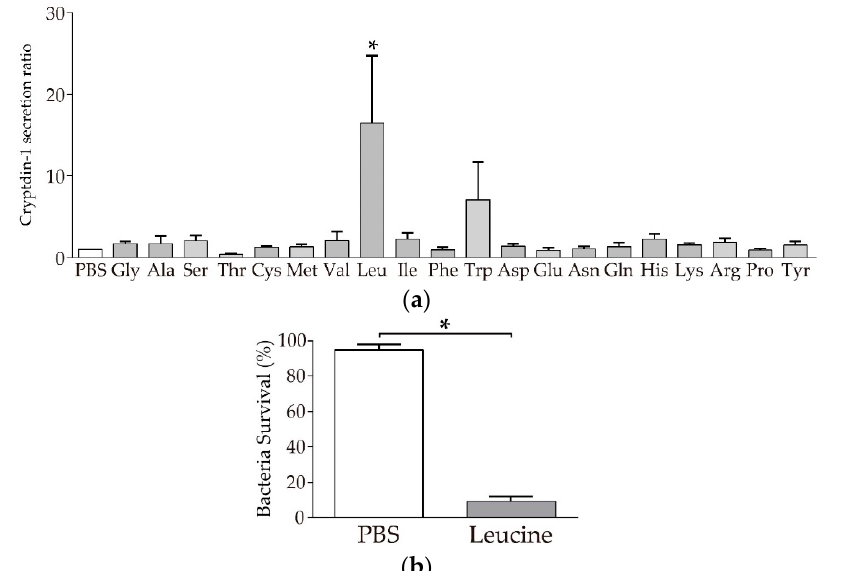
Figure 2. Induction of Crp1 secretion from Paneth cells by amino acids using isolated crypts of the mouse small intestine: ( a ) Induction of Crp1 secretion by Paneth cells in response to 1 µM amino acids. The results are shown as a relative ratio of Crp1 concentration compared to PBS. Data are expressed as the means ± SEM ( n = 3–6). * p < 0.05 by Tukey’s multiple comparisons test. ( b ) Bactericidal activities of Paneth cell secretion stimulated by leucine and PBS control against S. typhimurium . Data are expressed as the means ± SEM ( n = 3). * p < 0.05 by Student’s t -test.